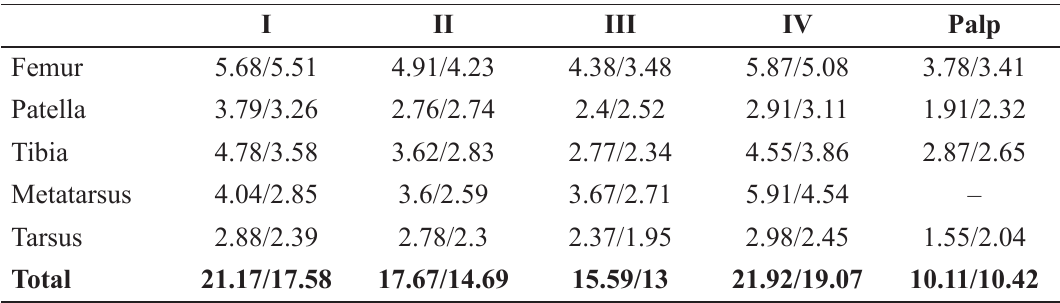
Table 6. Length of legs and palpal segments of holotype, ♂ (MZSP 28420) / paratype, ♀ (MZSP 26081) of Schismatothele timotocuica sp.